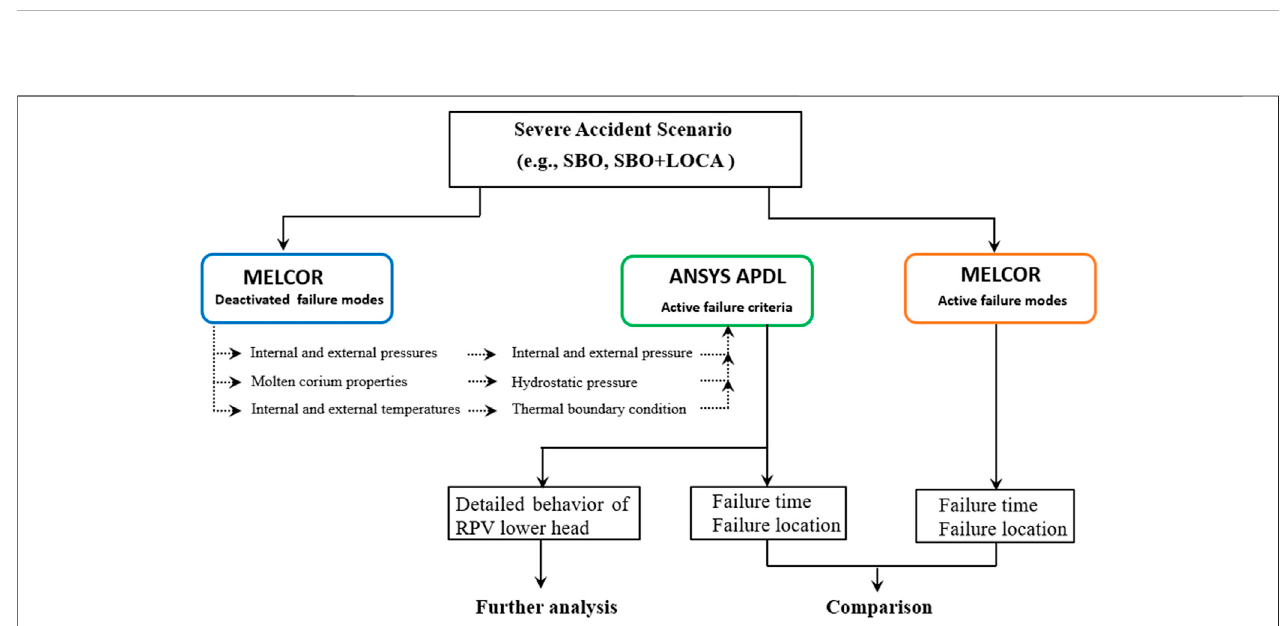
FIGURE 1 | Framework of thermo-mechanical analysis for a Nordic BWR with SBO and SBO + LOCA scenarios.